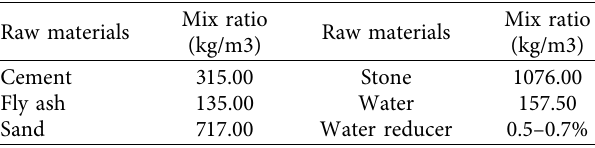
Table 9: Concrete mix